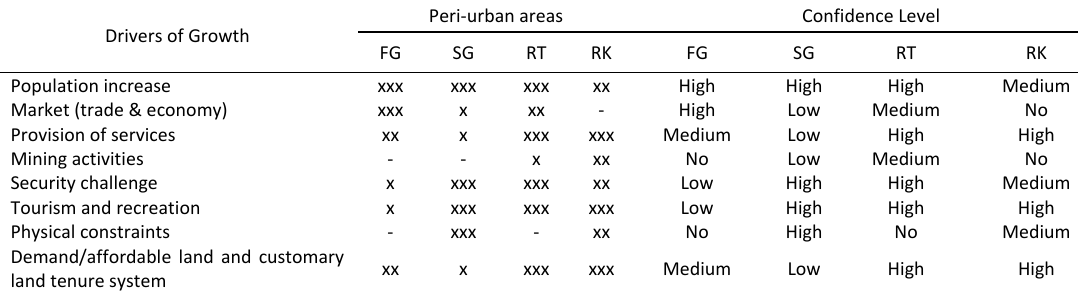
Fig. 8: Sporadic nature of growth in peri‐urban areas of Jos Table 7: Drivers of growth in Jos peri-urban areas Table 7: Drivers of growth in Jos peri-urban Drivers of Growth